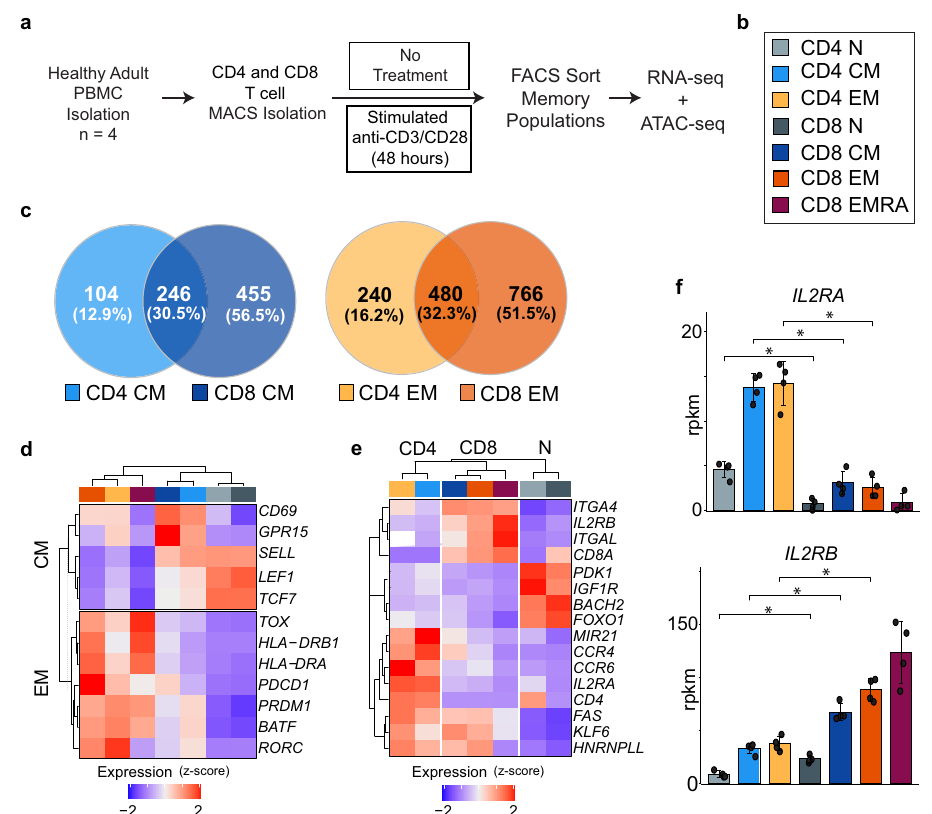
Fig. 1 MTC display distinct patterns of shared and differentially expressed genes that de fi ne their subsets and lineage. a Experimental work fl ow for isolation, ex vivo stimulation, and sequencing analysis of MTC from human blood samples. b Color code of naïve T cell and MTC lineages and subsets used throughout are shown. c Venn diagrams representing total number of DEG for T CM and T EM compared to naïve T cells. d Heatmap and hierarchal clustering of gene expression for select genes commonly expressed in either T CM or T EM regardless of lineage. e Heatmap of lineage-speci fi c gene expression in MTC. f Gene expression bar plots (reads per kilobase million, rpkm) for indicated IL-2 receptor genes. Data are plotted as mean ± SD (standard deviation); asterisks indicate DEG (FDR ≤ 0.05) as detected by DESeq2 algorithm. Cell type color codes are shown in ( b